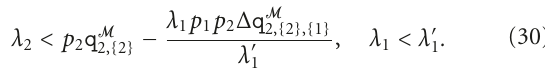
and by symmetry, the stability region of S { 2 }